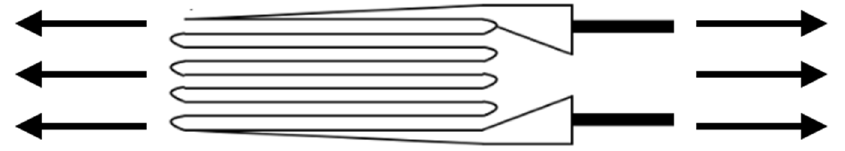
Figure 10. Representation of the unidirectional strain gauge sensor and the effective strain direction of the grid.